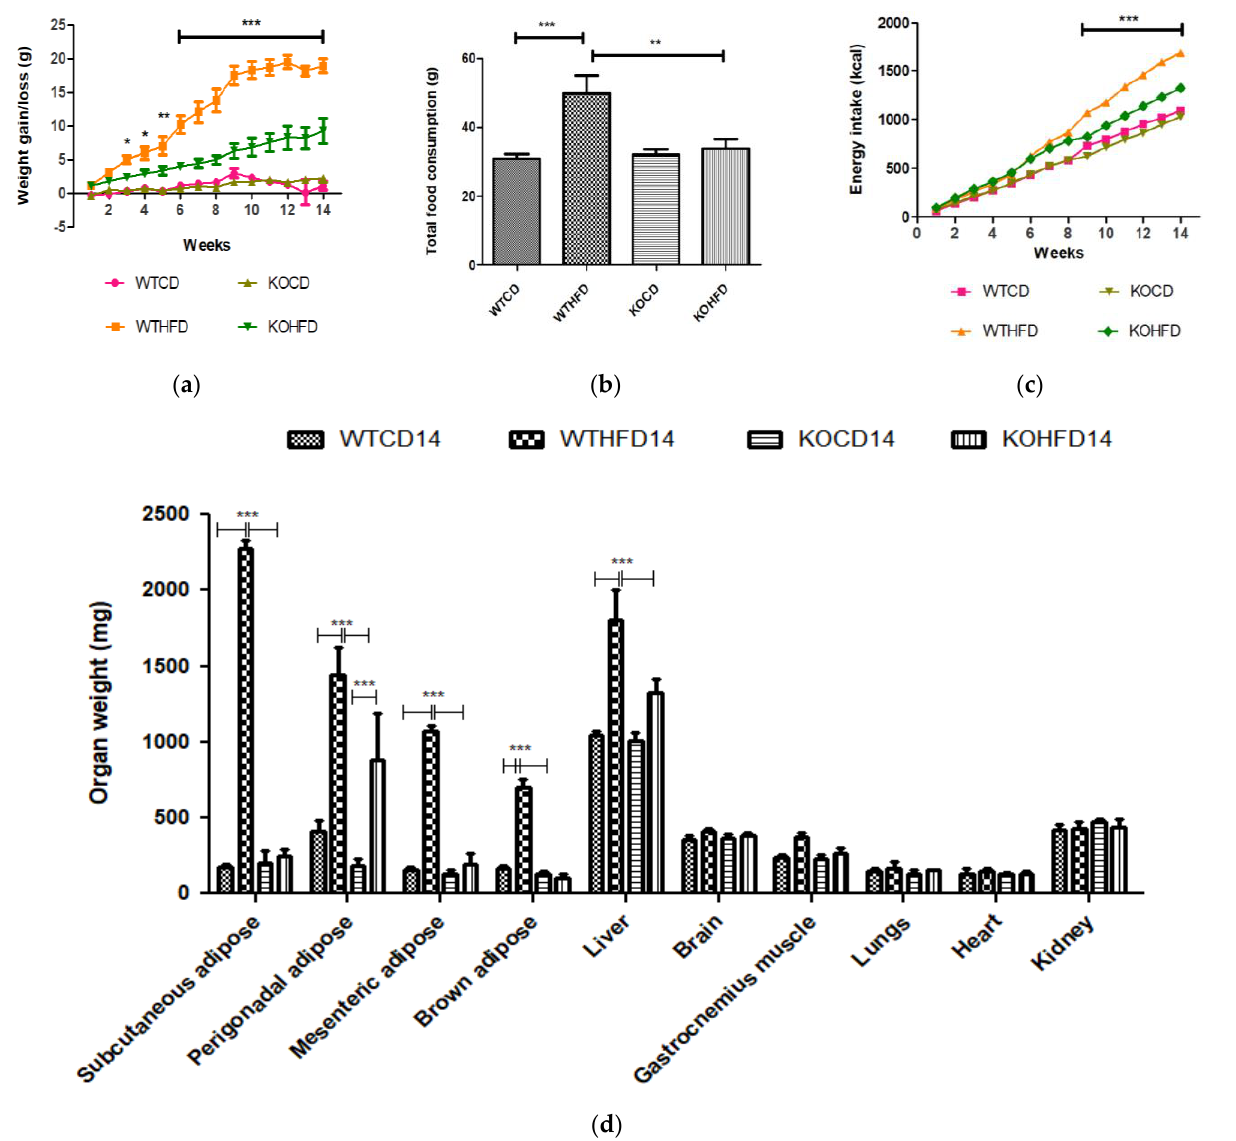
Figure 1. Effect of slc7a8 deletion on body weight and caloric intake. ( a ) WTHFD gained significantly more weight throughout the 14-week period starting from week 2 than did WTCD ( p < 0.05 to p < 0.001). KOHFD gained significantly more weight than KOCD ( p < 0.05). The difference in weight gain between WTHFD and KOHFD was significant starting in week 3, with the p -value decreasing gradually from p < 0.05 to p < 0.001. WTCD and KOCD showed no differences in weight. ( b ) Total cumulative food consumption was significantly greater in WTHFD than in WTCD ( p < 0.001) and KOHFD ( p < 0.01). Energy intake increased significantly (from p < 0.01 at week 5 to p < 0.001 from week 6 to week 14) between WTCD and WTHFD. ( c ) A significant difference ( p < 0.001) in caloric intake was observed between WTHFD and KOHFD from week 11 to week 14. Comparisons between KOCD and KOHFD revealed significant differences in calorie intake, with p < 0.05 at week 3, p < 0.01 at week 4, and p < 0.001 from week 5 to 14. No significant differences in caloric intake were seen between KOCD and WTCD. ( d ) WTHFD showed significantly larger ( p < 0.001) iWAT, pWAT, mWAT, BAT, and liver compared to WTCD and KOHFD. Week 1 – 5: N = 18 for WTCD, WTHFD, and KOHFD and N = 17 for KOCD; week 6 – 8: N = 12 for WTCD, WTHFD, and KOHFD and N = 11 for KOCD; week 9 – 12: N = 6 for WTCD, WTHFD, and KOHFD and N = 5 for KOCD; week 13 – 14: N = 5 for WTCD, WTHFD, and KOCD and N = 6 for KOHFD. * p < 0.05, ** p < 0.01, *** p < 0.001.